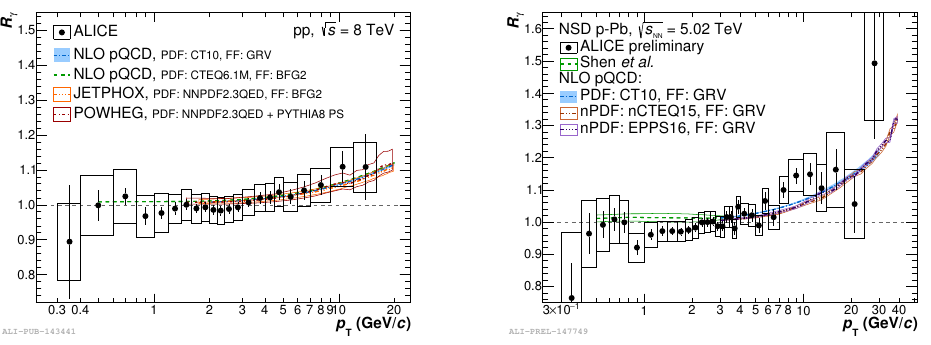
/ N dec = 1 + N coll N NLO . We can conclude that γ γ (cid:28) (cid:27)